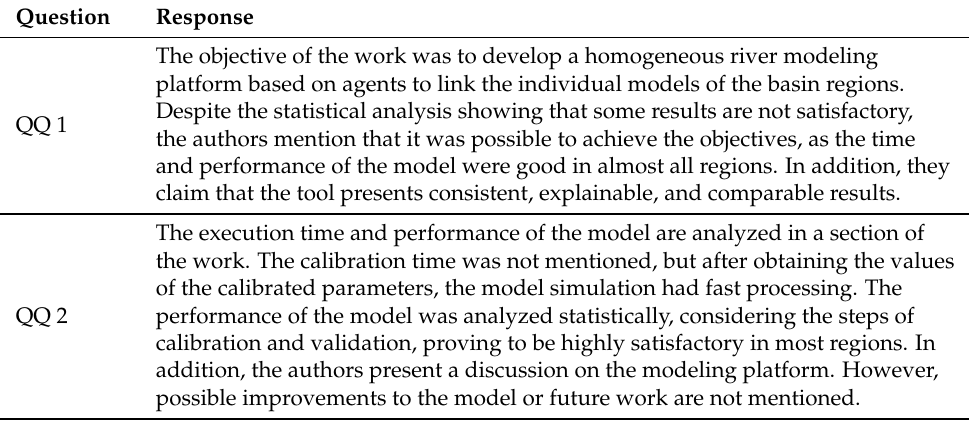
Table A4. Answers of quality questions about the work of Yang et al.